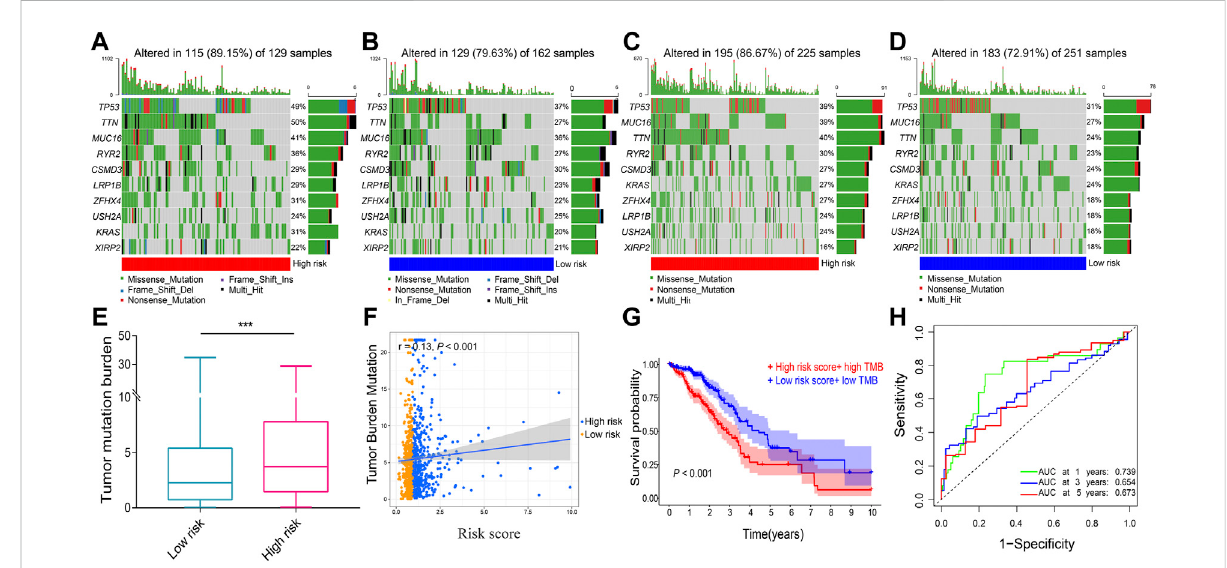
FIGURE 8 The tumor mutation analysis. Comparison of gene mutation frequencies in the high-risk group of (A) LUAD and (C) LUSC. Comparison of mutation frequencies in the low-risk group (B) LUAD and (D) LUSC (E) Boxplot illustrated that the TMB value was signi fi cantly higher in the high-risk group in NSCLC (F) Scatter plot of correlations between the TMB value and the risk score in NSCLC (G) Kaplan – Meier survival curve between the high-risk score + high TMB group and the low-risk score + low TMB group (H) ROC curve analysis. LUAD, lung adenocarcinoma. LUSC, lung squamous cell carcinoma; NSCLC, Non-small cell lung cancer; TMB, tumor mutation burden; ROC, receiver operating characteristic. AUC, an area under the ROC curve. *** p <